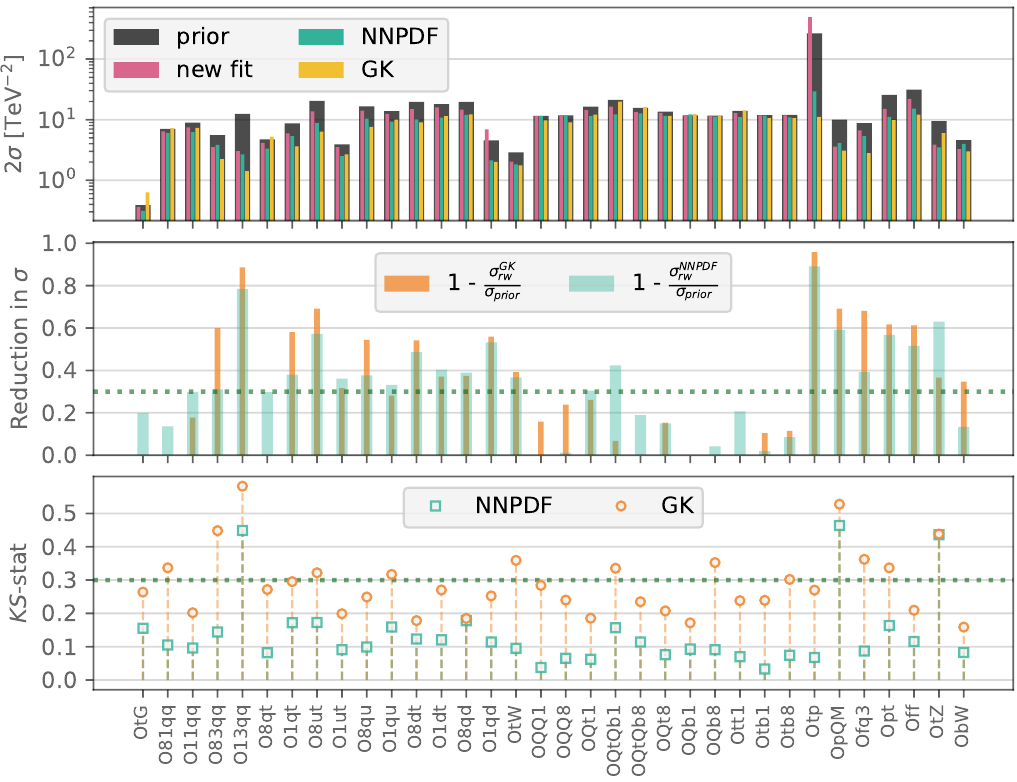
Figure 4.1: Same as Fig. 3.3, but for reweighted results obtained either with the NNPDF or the GK